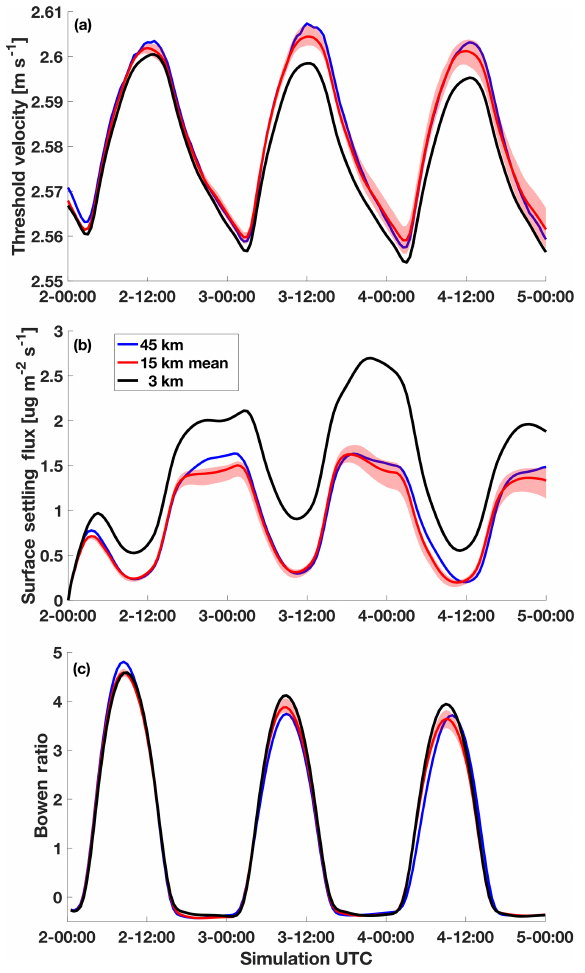
Figure 5. Spatially averaged (a) dust uplift threshold velocity, (b) dust surface settling flux, and (c) the Bowen ratio of sensible to latent heat flux. Colors and shading are the same as in Fig. 4.